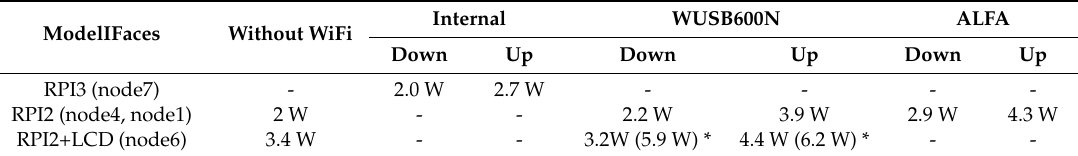
Table 8. Average-power consumed in every configuration.